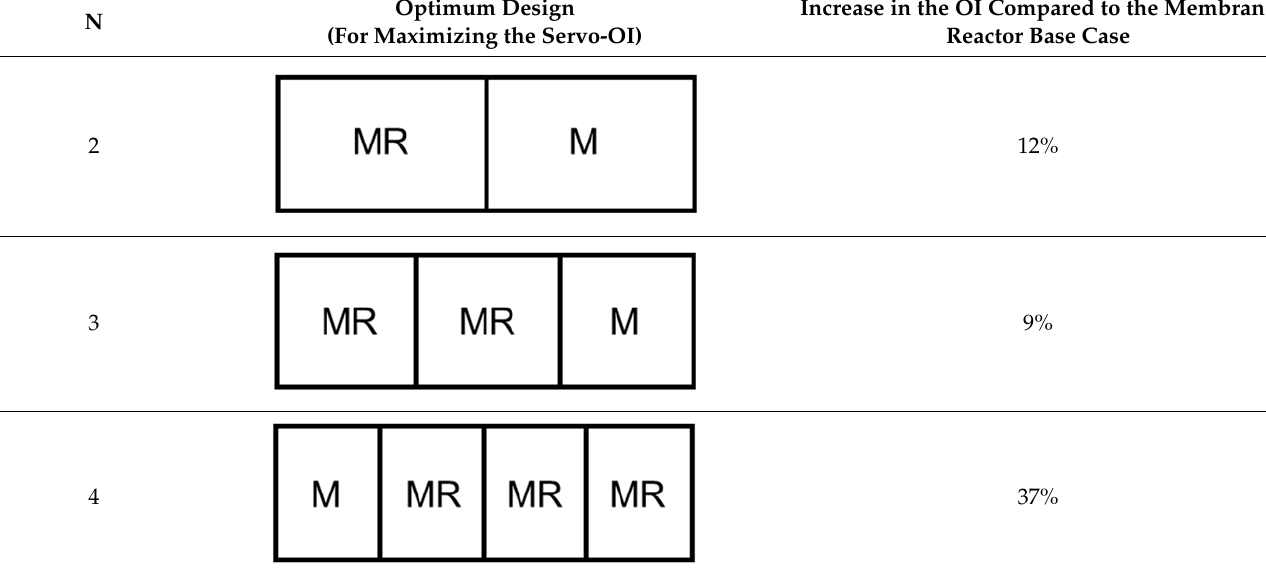
Table 3. Summary of the operability and optimization analyses for maximizing the servo-OI.